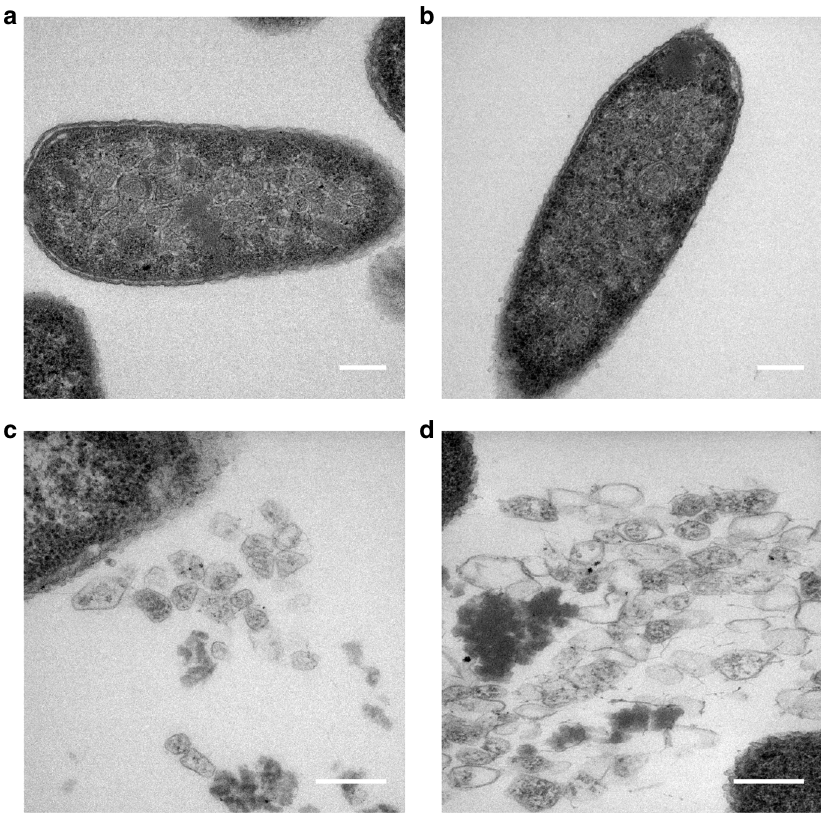
Fig. 5 Expression of circularly permuted BMCs. TEM analyses of resin embedded, thin sectioned, E. coli BL21 * (DE3) cells producing wild type PduA BMCs and circularly permuted PduA P BMCs. a , c PduA-U in-vivo and isolated ( b , d ) PduA P -U. Scale bars show 0.2 µ